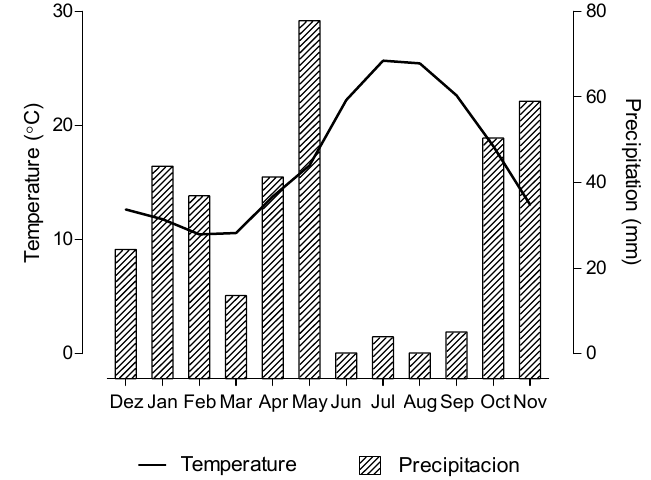
Figure 5. Environmental temperature and precipitation between December 2015 and November 2016.